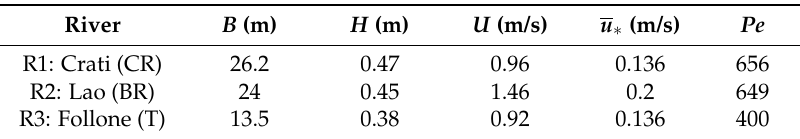
Table 1. Summary of the main geometric and hydrodynamic parameters for the cases under